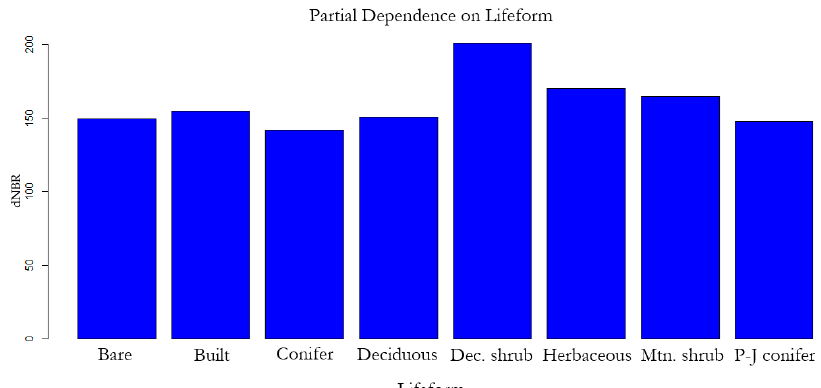
Figure 10. Deciduous vegetation with a shrub stature follows higher severity fire. Aspen, locust, mahogany, and gambel oak dominate the shrub lifeform category. This coincides with a higher surface roughness. Pinyon-juniper (P-J) is found near the canyon rim, in more xeric locations. Partial dependence plots illustrate the relationship between fire severity and elevation (Figure 11). The lowest elevation has pinyon-juniper forests, the bottom of the curve with low severities falls in the elevation where ponderosa pine dominates. Higher severities occur in the mixed conifer and spruce-fir dominated forest types at the highest elevations of the Kaibab plateau.